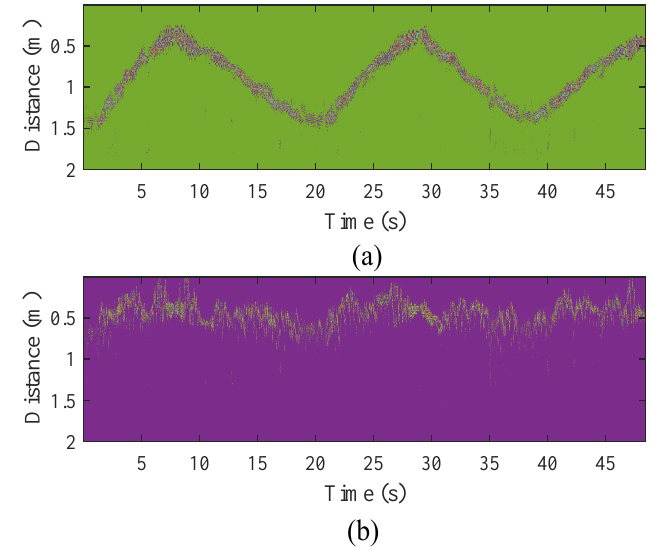
Figure 6. Echos ( a ) before and ( b ) after body movements’